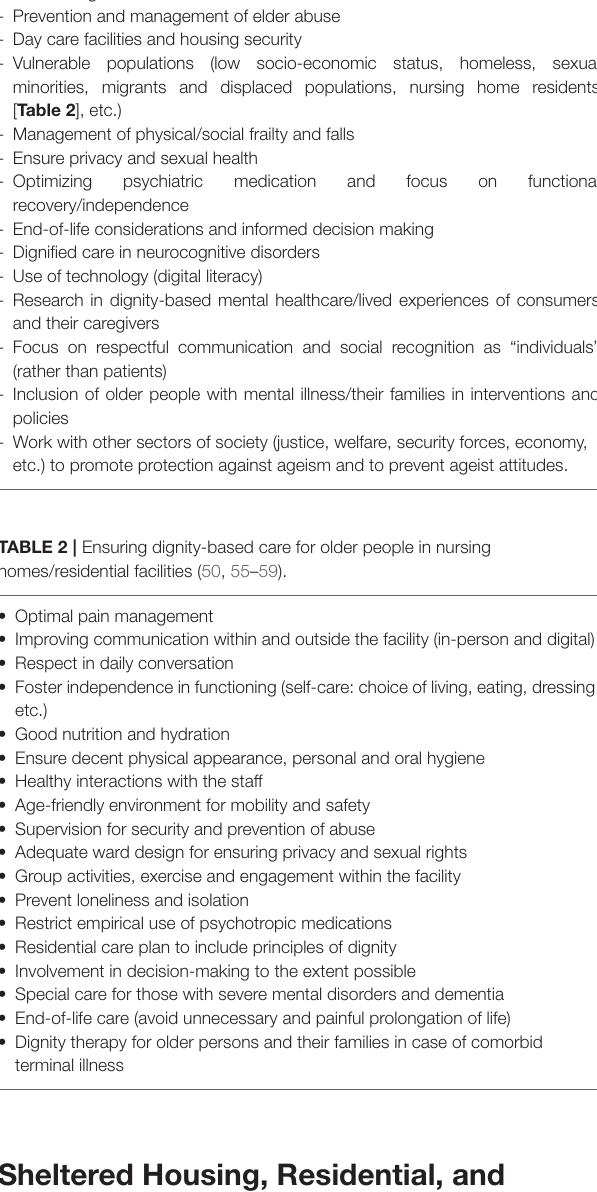
[ Table 2 ], etc.) - Management of physical/social frailty and falls - Ensure privacy and sexual health - Optimizing